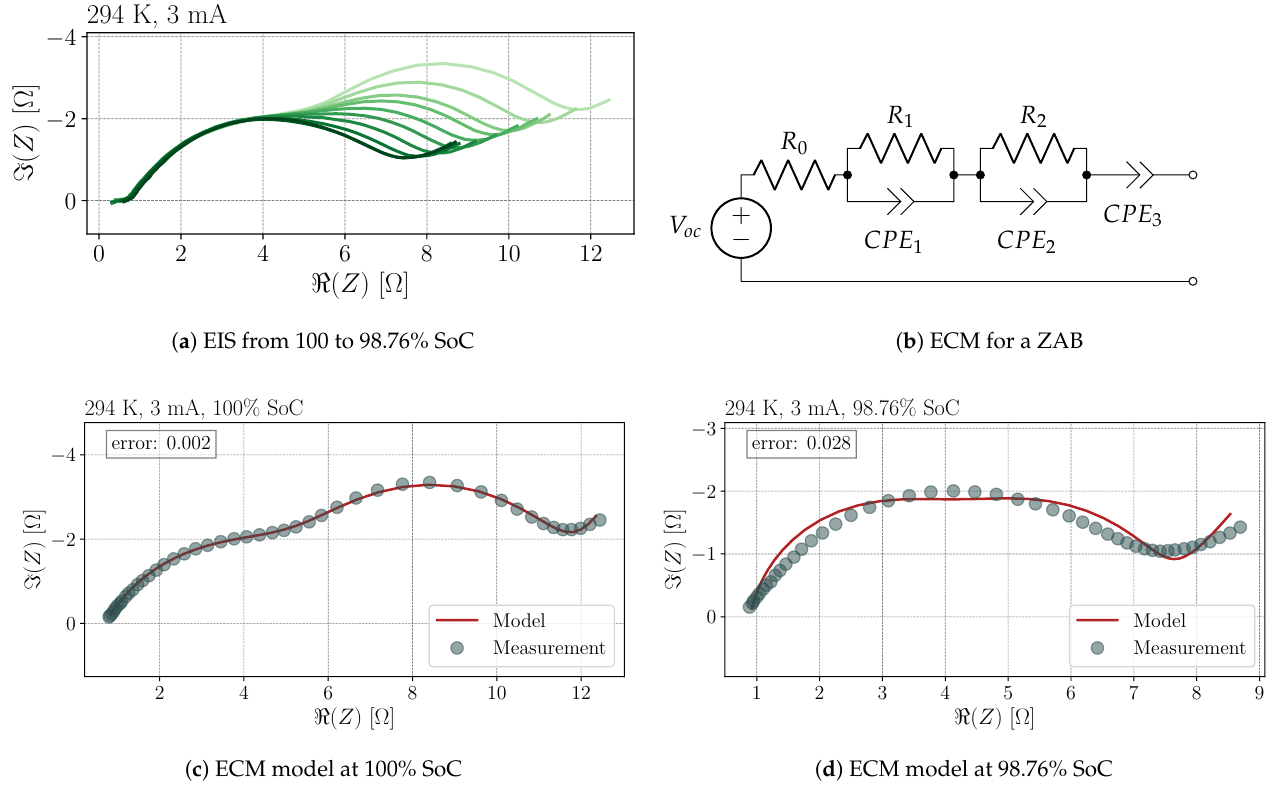
Figure 8. Process analysis of a ZAB at 294 K and a discharge current of 3 mA. ( a ) shows the EIS and ( b ) represents a corresponding equivalent circuit. ( c , d ) depict the reconstructed EIS from the ECM.